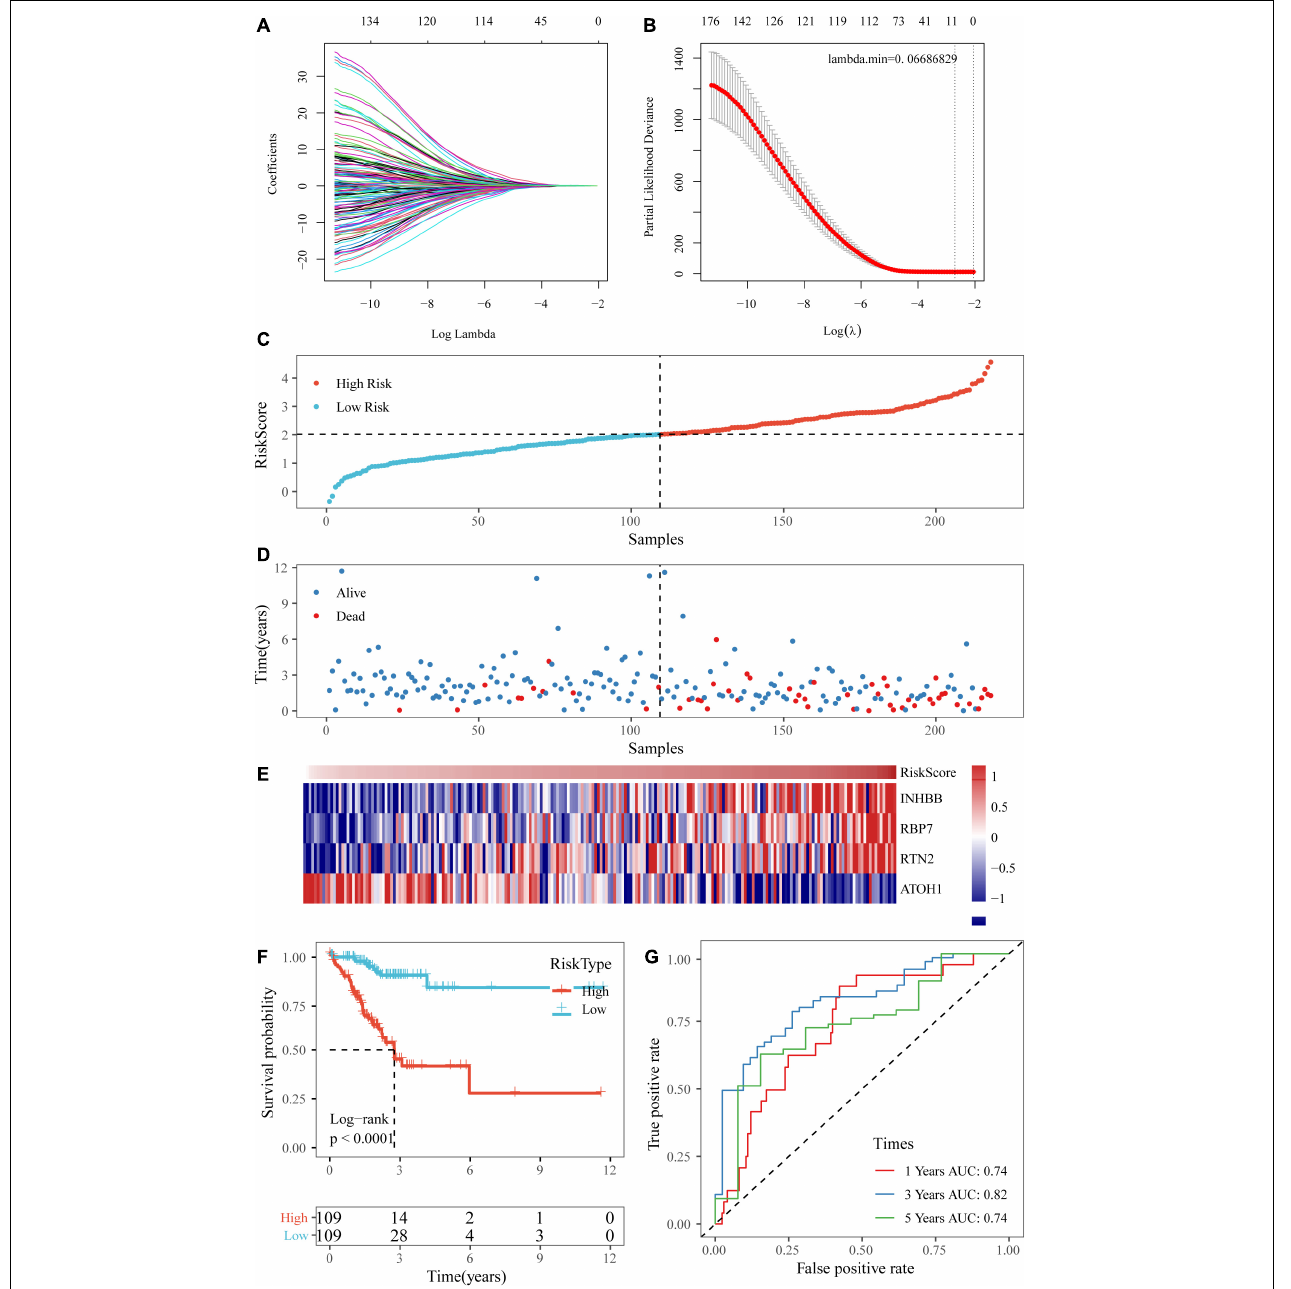
FIGURE 6 | Establishment of a prognostic risk scoring system based on four genes. (A,B) A larger λ indicating a greater penalty for the linear model with more variables. (C,D) The distribution of risk scores in TCGA training dataset and the distribution of corresponding survival states. (E) Heatmaps of gene expression in the risk score model. (F,G) KM curves and ROC curves of the risk score in TCGA training datasets.